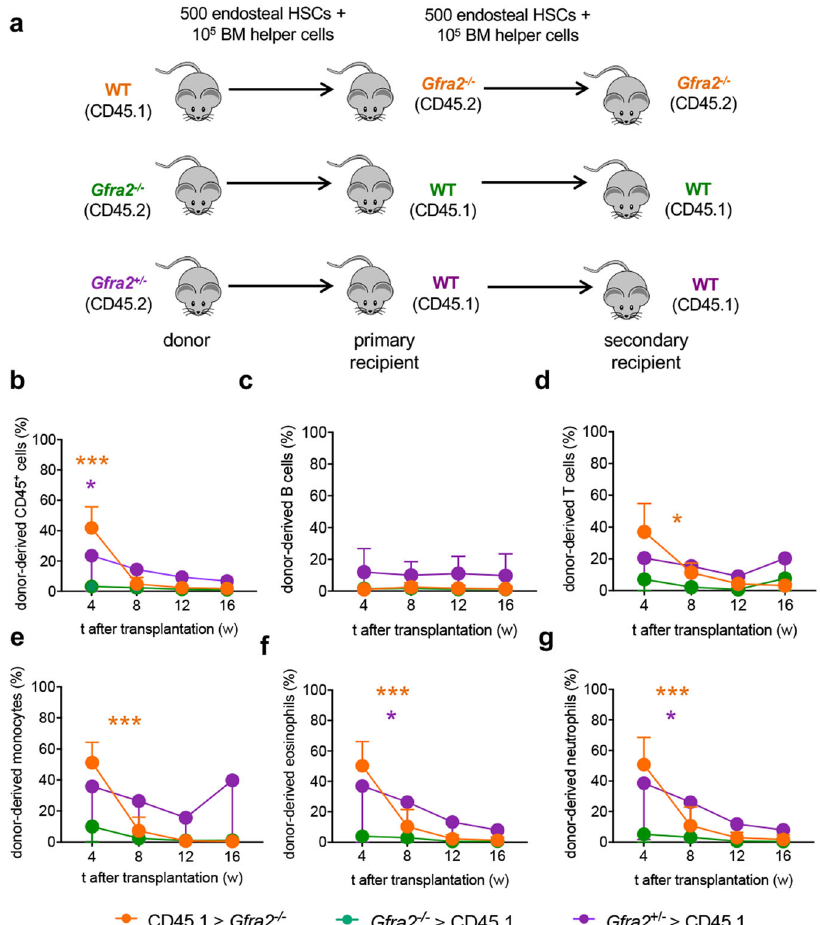
Fig. 6 Reduced HSC self-renewal in a cholinergic-neural-de fi cient niche. a Scheme illustrating competitive serial HSC transplantations. 500 endosteal LSK CD48 − CD150 + HSCs isolated from primary recipients were i.v. injected together with 10 5 BM helper cells into lethally irradiated secondary recipients of the same genotype as the primary recipient mice. b – g Donor-derived haematopoietic chimerism ( b ), B cells ( c ), T cells ( d ), monocytes ( e ), eosinophils ( f )